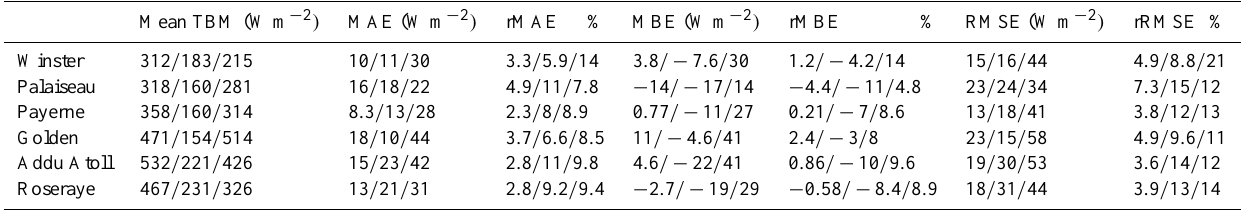
Table 6. SPN1 vs. TBM comparison scores before and after slope calibration (three values at each cell, corresponding to GHI, DHI and DNI irradiances respectively).